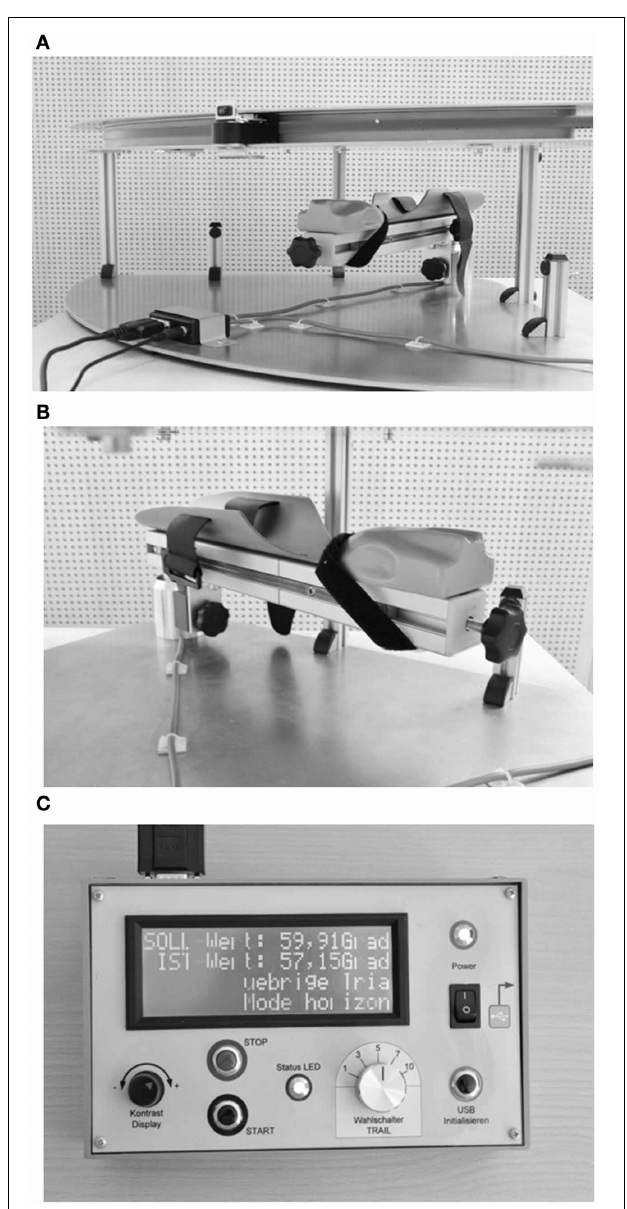
FIGURE 1 | (A) Layout of the arm position device (APD, see text for further details). (B) Arm support. (C) Control panel.